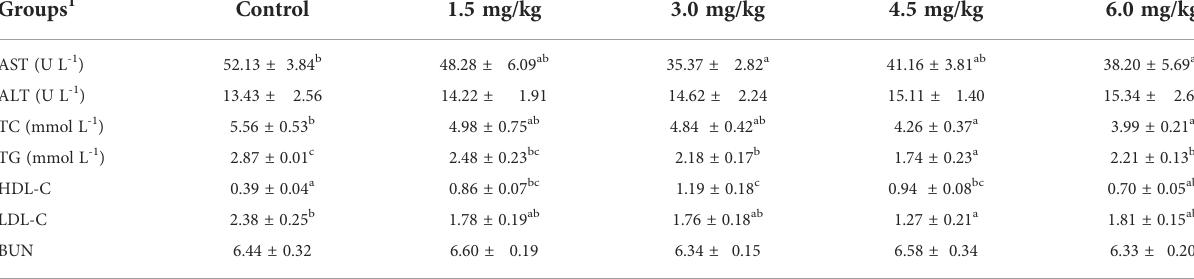
TABLE 5 Effects of PQQ on serum biochemical parameters of yellow cat fi sh. Groups 1